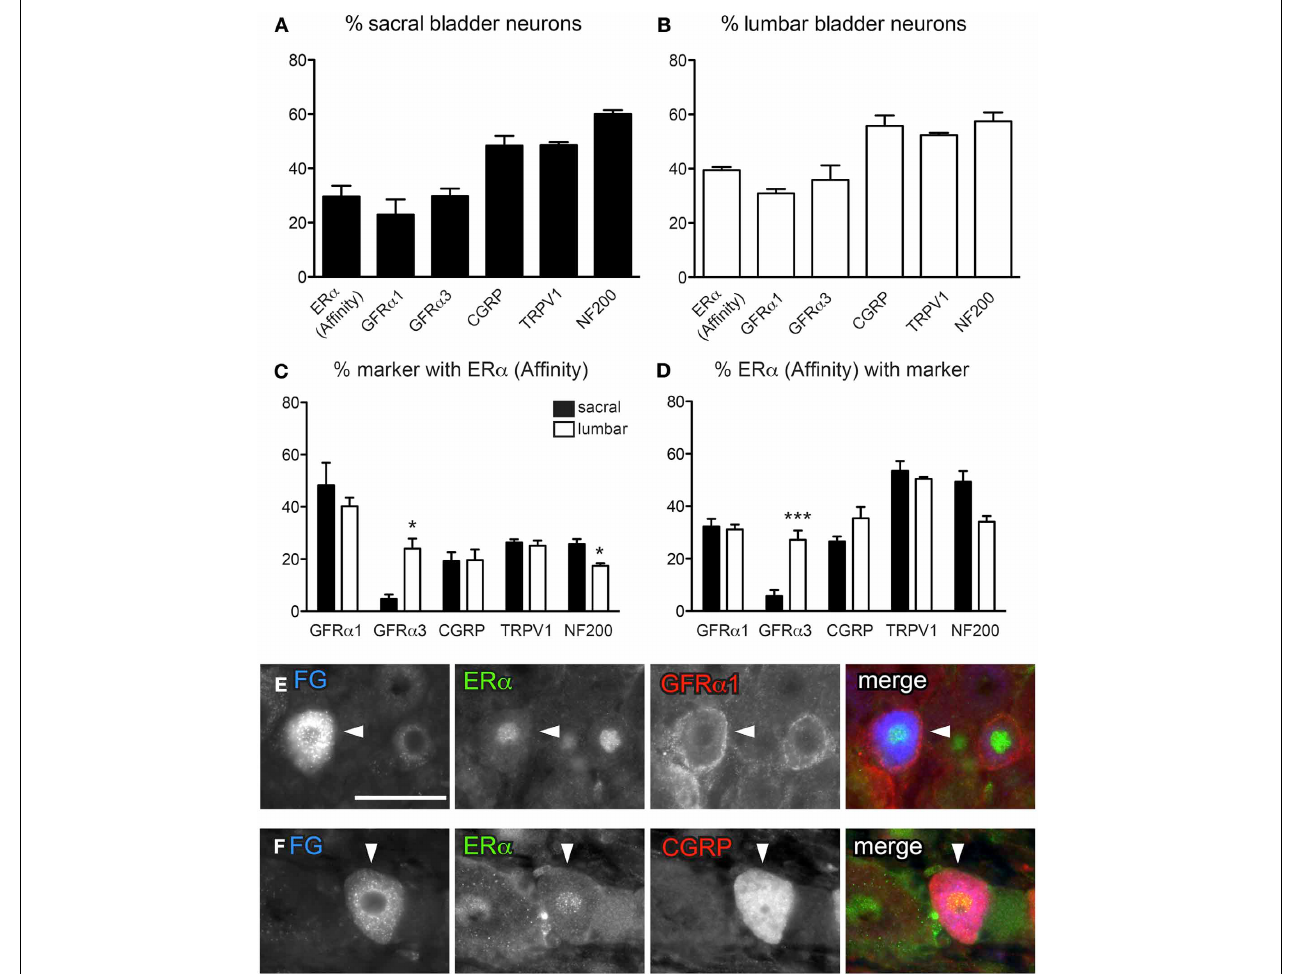
FIGURE 2 | Distribution of ER α and GFRs in bladder sensory neurons. This figure illustrates immunostaining for ER α using the antibody purchased from Affinity Bioreagents. (A, B) The proportion of sacral (A) and lumbar (B) bladder-projecting neurons containing ER α -, GFR α 1, GFR α 3-, CGRP-, TRPV1-, and NF200-immunoreactivity (IR). (C) The proportion of GFR α 1-, GFR α 3-, CGRP-, TRPV1-, and NF200-IR bladder sensory neurons containing ER α -IR. A higher proportion of GFR α 3-IR neurons contained ER α -IR in lumbar vs. sacral DRGs ( ∗ P = 0.01), whereas a higher proportion of NF200-IR neurons contained ER α -IR in sacral vs. lumbar DRGS ( ∗ P = 0.03). (D) The proportion of ER α -IR bladder sensory neurons containing each marker. A higher